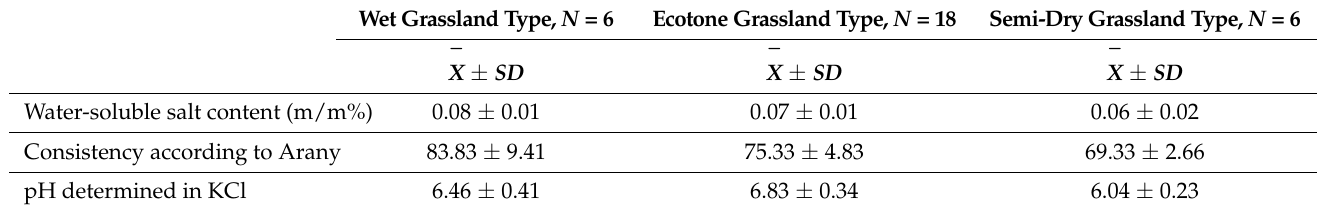
Table A4. Identification of the seed bank type of the species in the three grassland types with different water regimes. The table contains only those species for which sufficient data were available in the given grassland type for reliable classification, i.e., based on the above-ground vegetation and/or the soil seed bank, the frequency of the species ≥ 3 in the grassland type; in the case of exclusive occurrence in the above-ground vegetation, the total cover of the species ≥ 1% in the grassland type; in the case of occurrence in the soil seed bank, the total seed number (total number of seedlings found) of the species ≥ 3 in the grassland type.